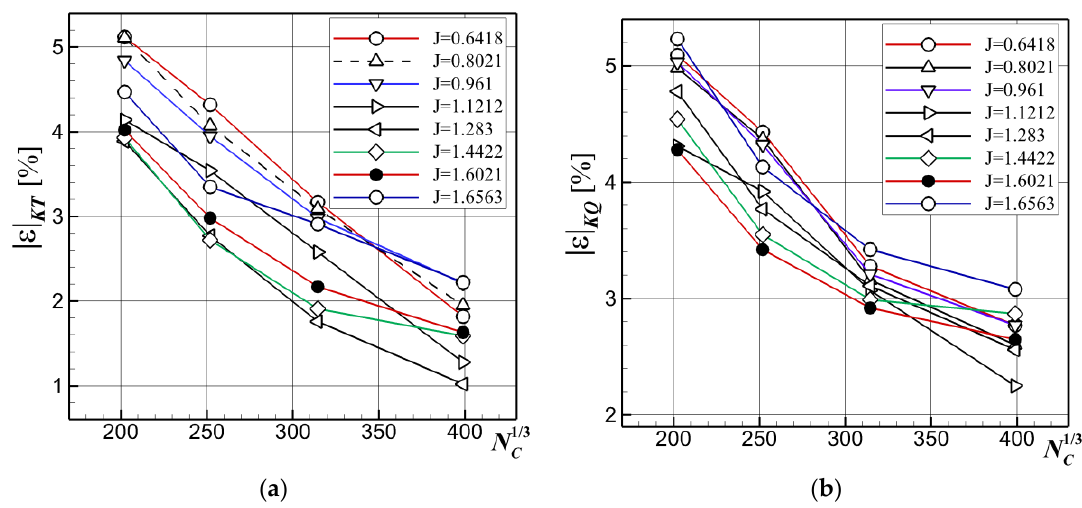
Figure 3. Computational error versus the cubic root of the cell numbers ( N C ). ( a ): K T ; ( b ): 10 K Q .